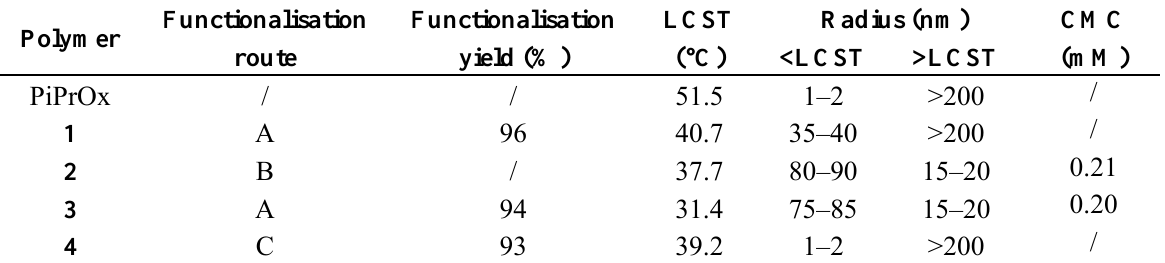
Table 2. Summary of characteristics of the single component systems